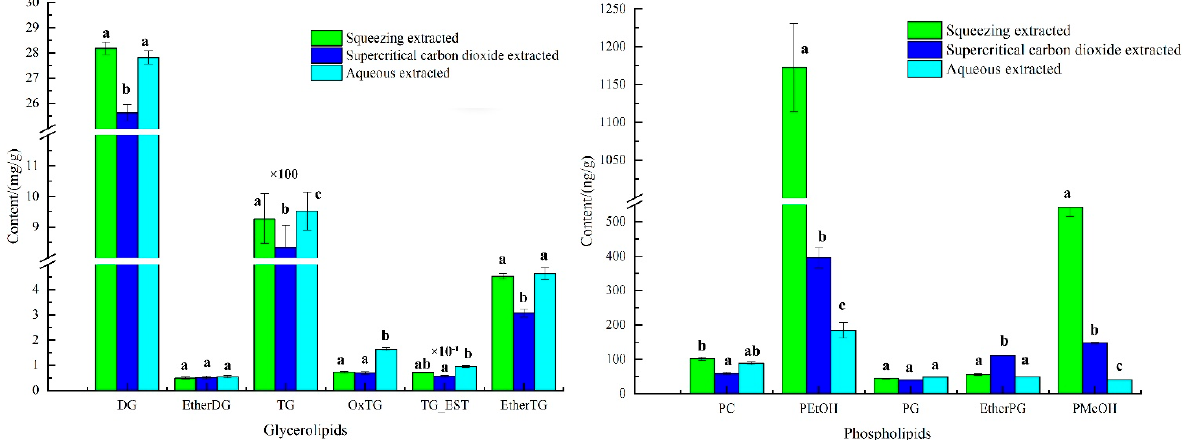
Figure 2. The composed of phospholipids and glycerides in avocado oil from three extraction methods. Note: Different letters a, b and c represented significant difference.